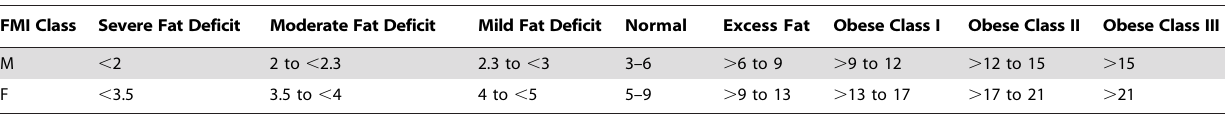
Table 4. Fat Mass Index (kg/m 2 ) classification